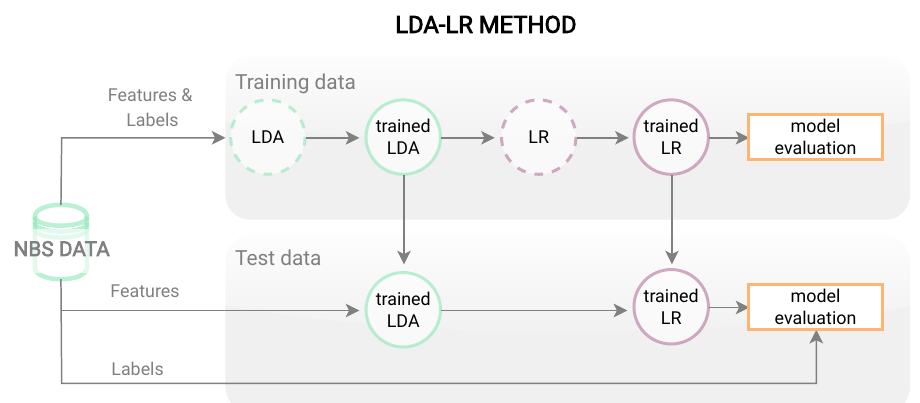
Figure 2. Workflow for LDA-LR method. Showing the training process with features and labels of the training data and evaluation of the trained methods on the test